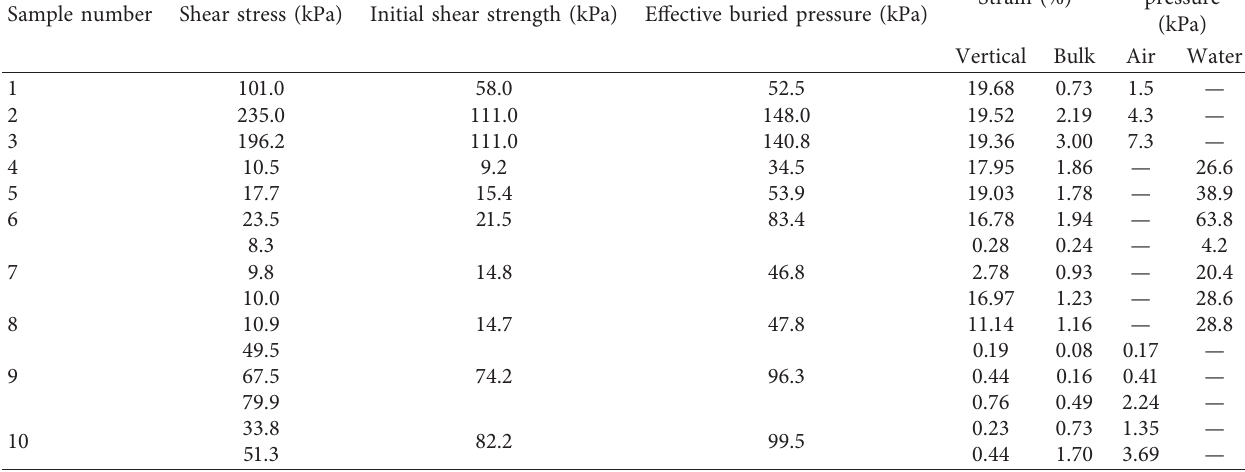
Table 2: The maximum values of corresponding testing data in laboratory for the normalization. Sample